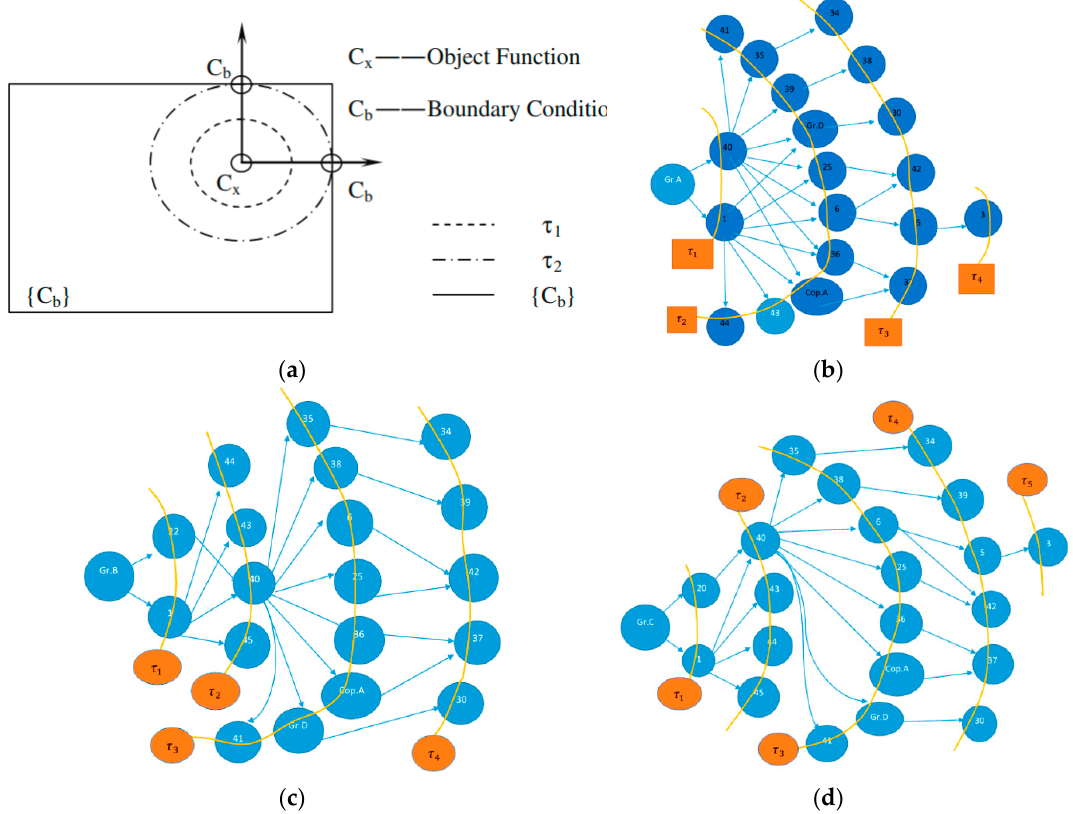
Figure 4. ( a – b ) Removal influence graph (RG); ( c – d ) The RG that enables the disassembly of group B Figure 4. ( a , b ) Removal influence graph (RG); ( c , d ) The RG that enables the disassembly of group B and group C. and group